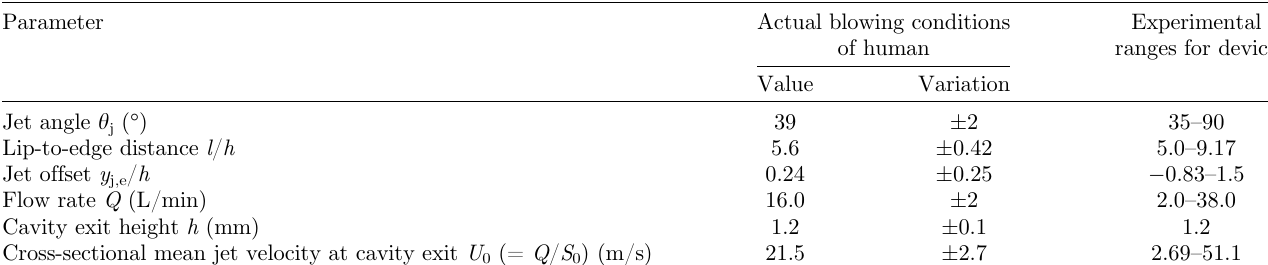
Table 1. Actual blowing conditions and experimental ranges.